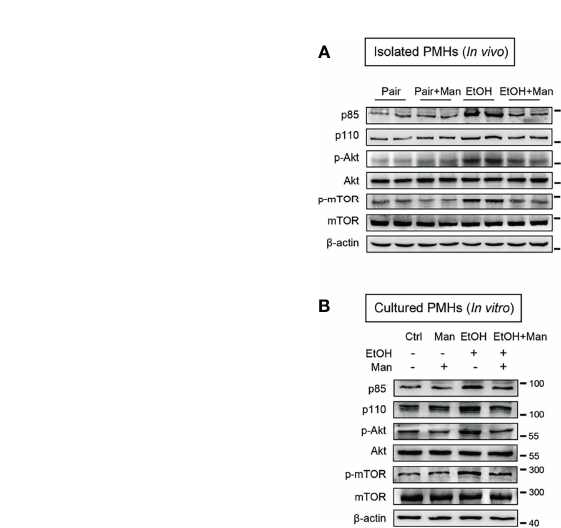
FIGURE 5 | Mannose suppresses ethanol-induced activation of PI3K/Akt/mTOR signaling pathway. (A) Isolated PMHs were obtained from mice fed the control diet (Pair) or ethanol diet (EtOH) supplemented with or without 3% (w/v) mannose (Man). The expression levels of PI3K-p85, PI3K-p110, p-Akt, Akt, p-mTOR and mTOR in isolated PMHs were analyzed by Western blotting (n = 6). (B) PMHs from WT mice were stimulated by 200 mM ethanol (EtOH) with/without 5 mM mannose (Man) for 24 h, PMHs with culture medium as control (Ctrl). PI3K-p85, PI3K-p110, Akt, p-Akt, mTOR and p-mTOR levels in cultured PMHs were determined (n = 3). Data are expressed as the mean ± SEM of three independent experiments. * p < 0.05, ** p < 0.01, *** p < 0.001, **** p < 0.0001, ns, not signi fi cant, unpaired two-tailed t